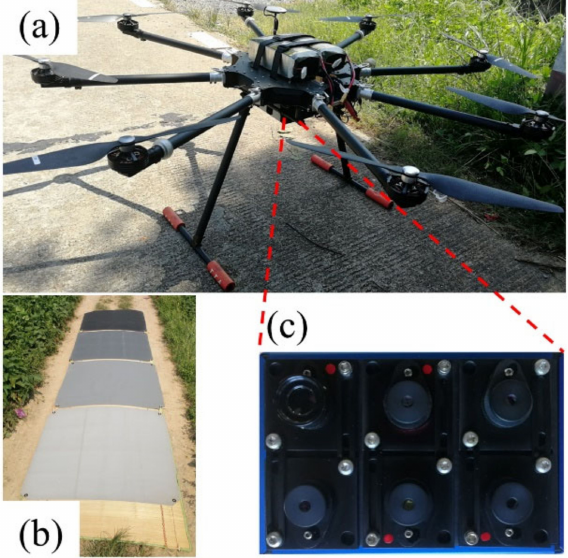
Figure 2. UAV reflectance-data-acquisition system: ( a ) UAV; ( b ) fixed reflectance grey plates for radiometric calibration; ( c ) Mini-MCA 6 multispectral